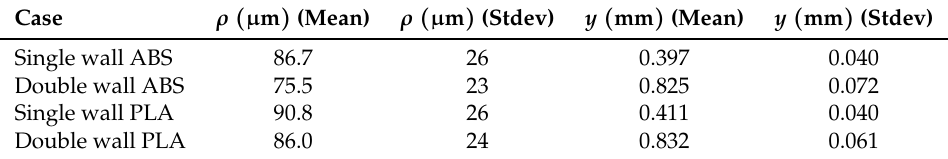
Figure 2. Mesostructure model for thin-walled fused deposition modeling (FDM) geometries, where: ( a ) represents a single wall and ( b ) represents a double wall. A series of samples were fabricated and measured to find the realistic expected ( c ) surface roughness and ( d ) wall thickness. Table 1. Surface roughness and wall dimensional accuracy measurements (from Figure